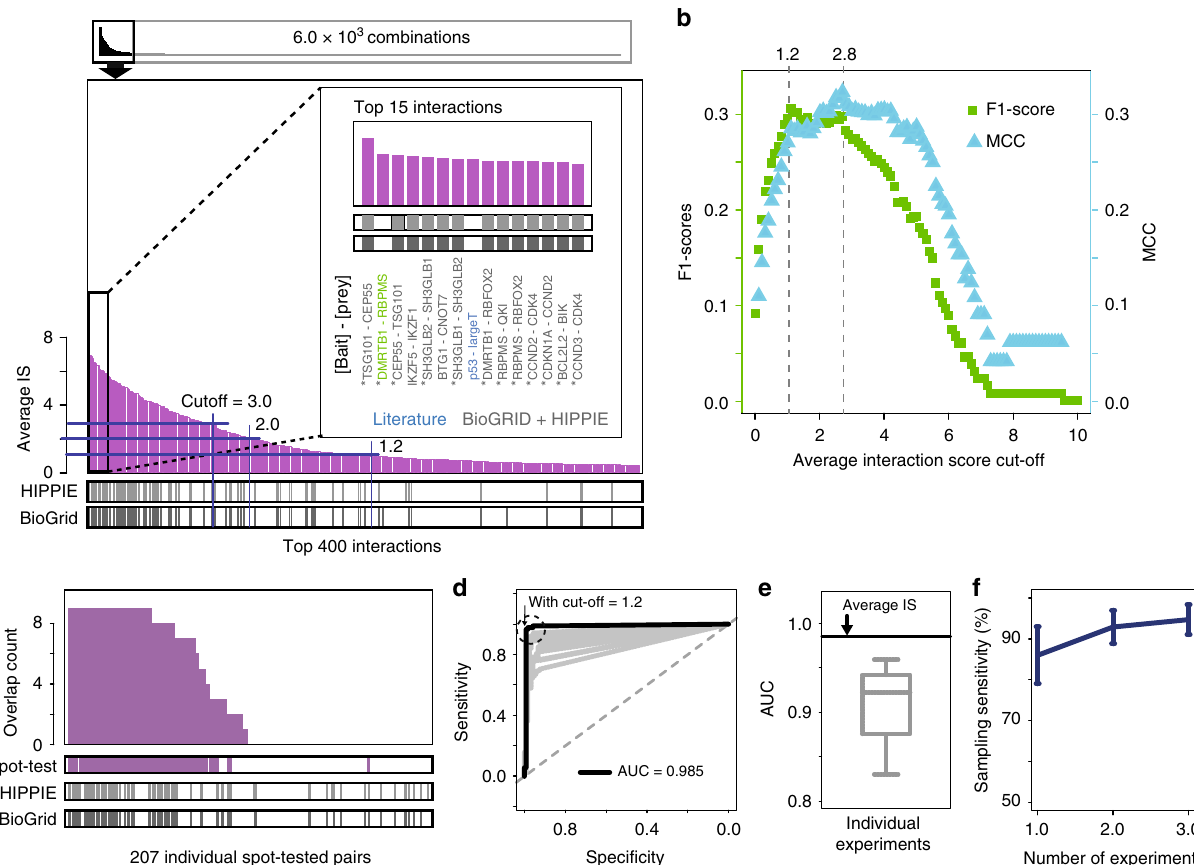
Fig. 3 rec-Y2H assay performance. a The top 400 protein pairs from the X71 screen having the highest average interaction scores (average IS). Bars at the bottom indicate if interactions were annotated in protein – protein interaction (PPI) databases. Top 15 pairs are further highlighted in the inset. Among them, 13 were found in PPI databases (grey). Asterisk indicates interactions detected above the cut-off (average IS = 1.2) in both orientations (Px-AD — Py-BD or vice versa). Blue indicates interactions not found in PPI databases, but described in the literature. Green indicates an interaction previously not reported. b Determination of the optimal interaction score cut-off based on the harmonic average of precision and sensitivity (F1-Score, green) and Matthews ’ s Correlation Coef fi cient (MCC, cyan). The performances were evaluated based on combined BioGRID and HIPPIE PPI databases. We stringently de fi ned all pairs not found in both databases as none-interacting pairs. c Comparison of interaction pair detection counts across experiments, individual spot test results (see Supplementary Fig. 9) and PPI databases giving an overall pairwise retest rate of 98.8%. Two hundred seven pairs were tested by spot test without homodimers. d Overall performance (AUC) of rec-Y2H based on the results of 207 individual spot tests. The black and grey lines indicate the averaged and individual experiments, respectively. The grey-dotted diagonal line shows random performance. e Distribution of the AUC for individual experiments. The box of the box plot illustrates the median, upper, and lower quartiles for AUCs. The black line and grey box-plot represent averaged and individual experiment performance, respectively. f Mean sampling sensitivity of single experiment 86.0%± 7.0% (average of nine individual experiments). The sampling sensitivity is already saturated after averaging just two experiments. Error bars represent standard